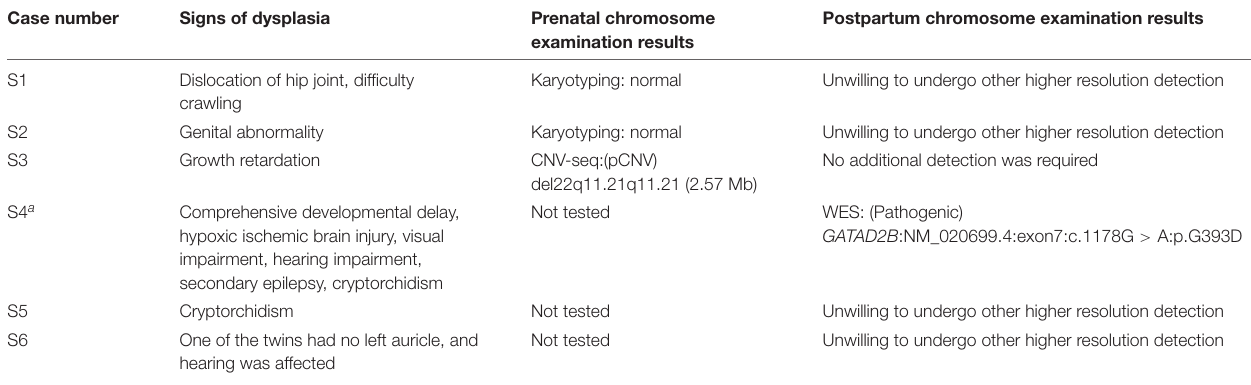
TABLE 4 | Overview of cases of postnatal dysplasia.